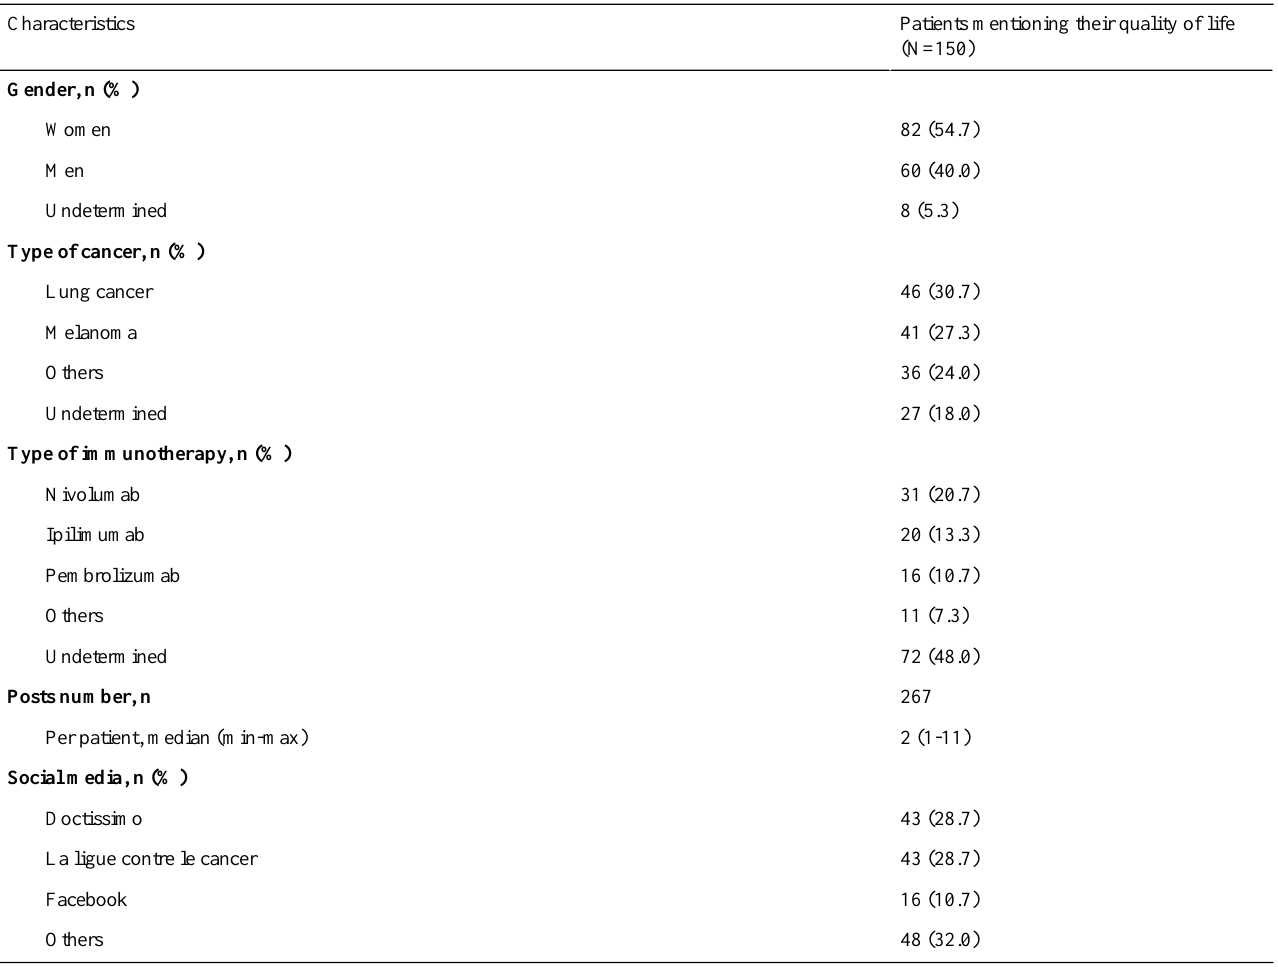
Table 1. Patients